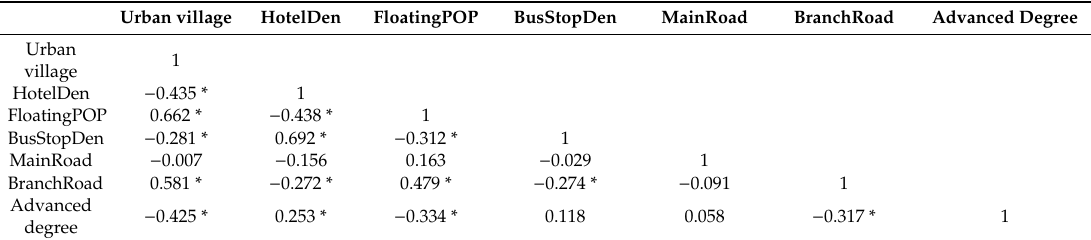
Table 2. Bivariate correlation coe ffi cient for explanatory